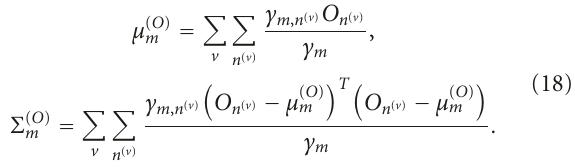
function is trained by (16) using the separated sequence